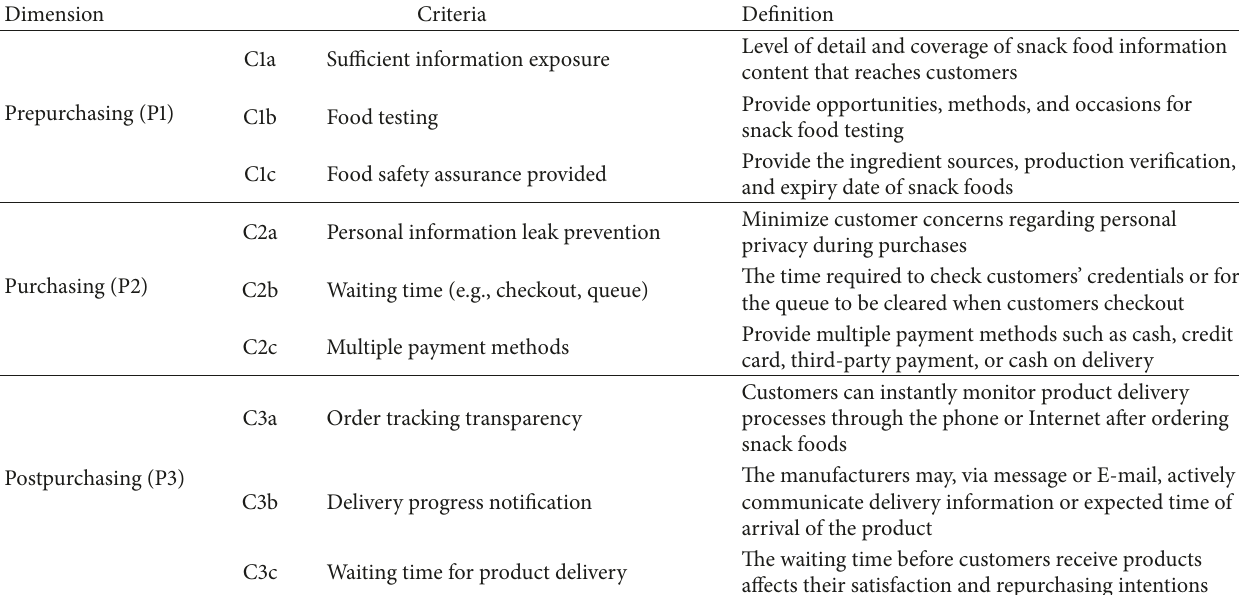
Table 1: Evaluation dimensions and criteria.